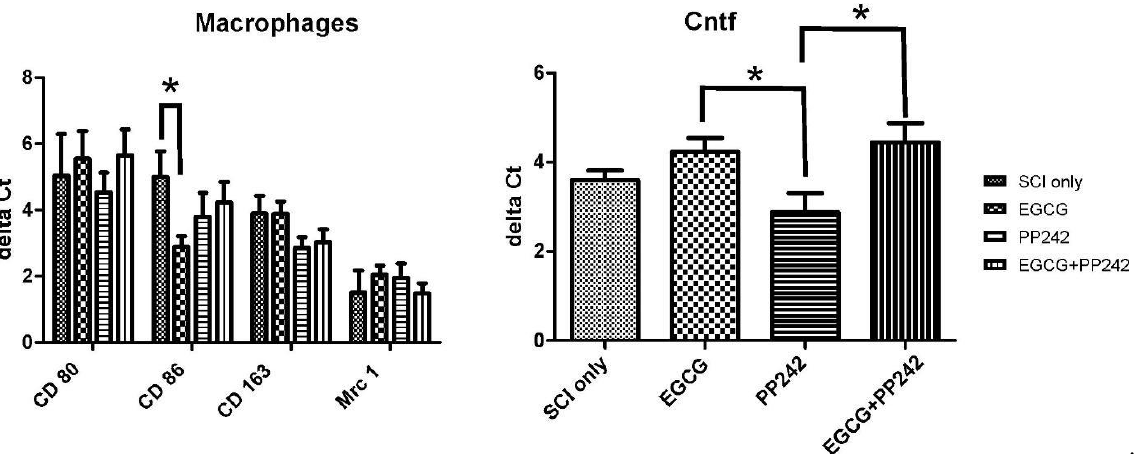
Figure 6. The qPCR analysis displayed lower expression of M1 macrophage marker, CD 86, after EGCG treatment compared to controls. The expression of Cntf (Ciliary neurotrophic factor) was significantly higher in the EGCG or PP242+EGCG treatment groups compared to PP242 or controls. This is evident from the higher expression of Cntf in EGCG-treated rats compared to the PP242-only group. * p < 0.05 indicates statistical significance.